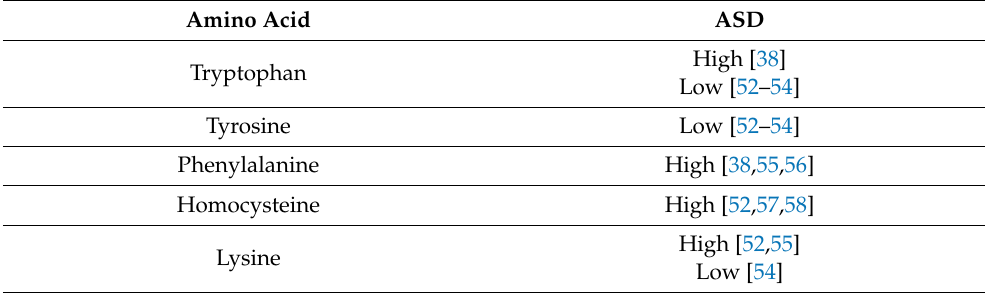
Table 1. Plasma levels of amino acids in individuals with ASD compared to individuals without